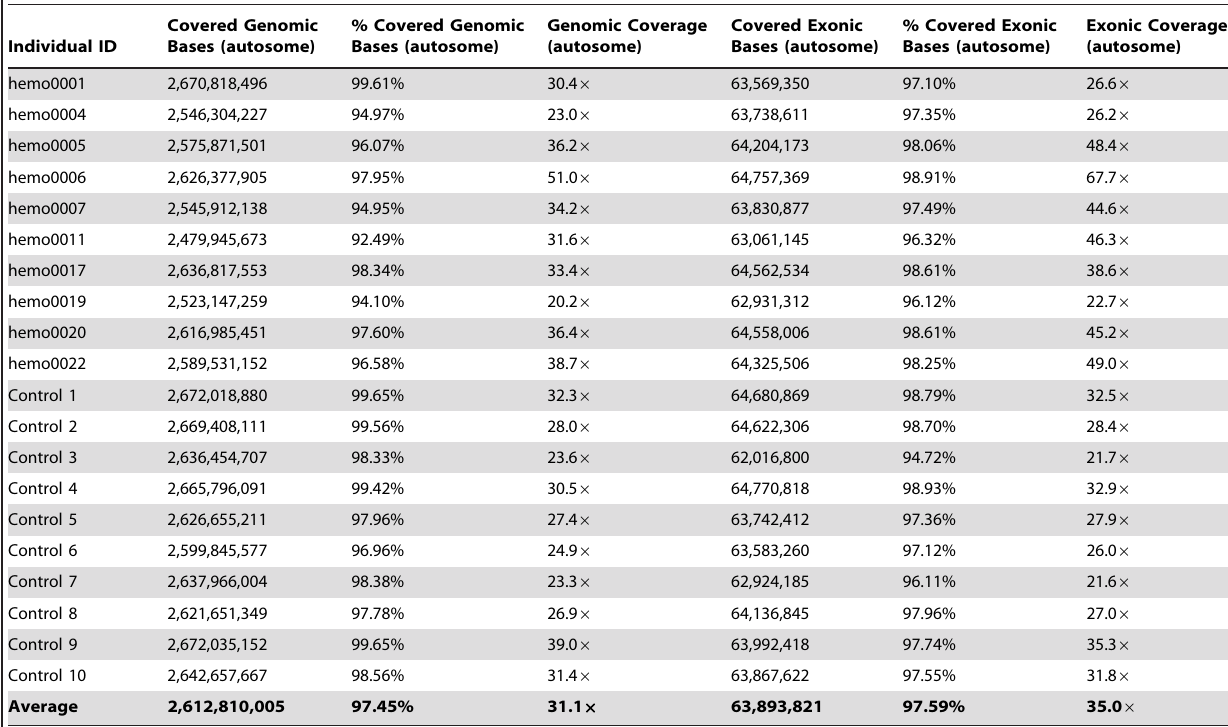
Table 1. Summary of genomic and exonic coverage in the twenty sequenced